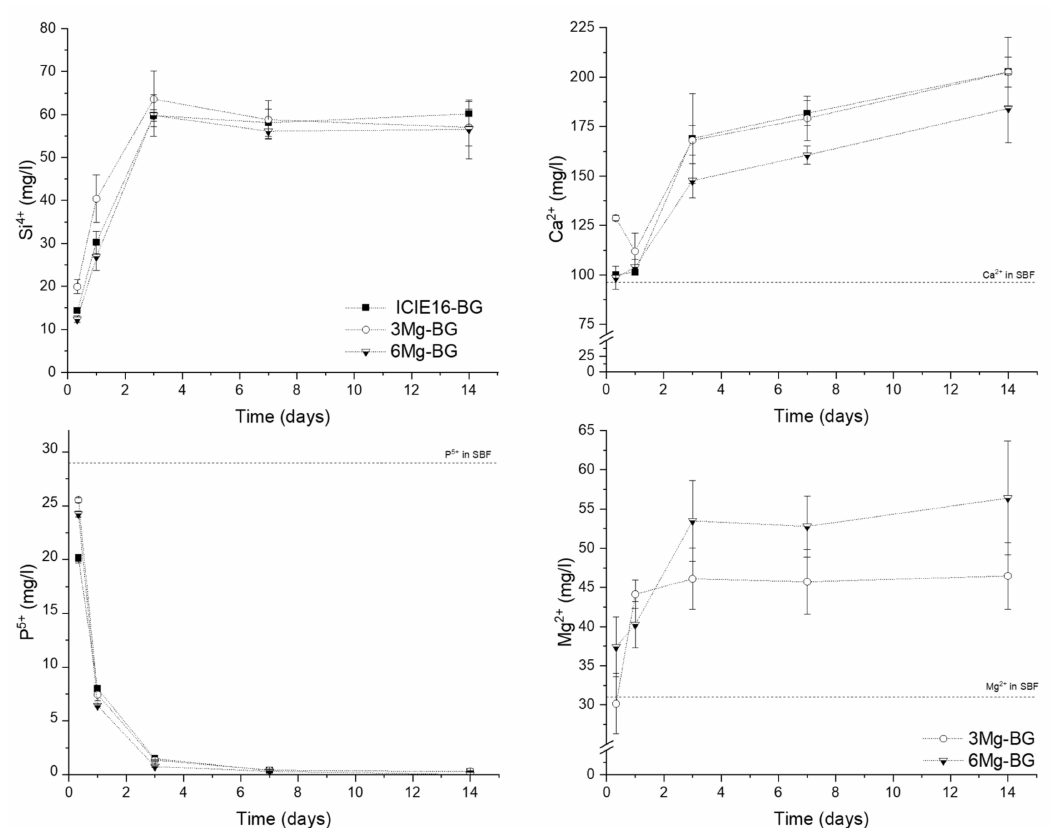
Figure 2. Ion release profiles of bioactive glasses (BGs) as function of incubation time in simulated body fluid (SBF). 2.2. Mg 2+ -Containing BGs Reduced Cell Proliferation Whilst Showing a Similar Influence on Viability as the ICIE16-BG While all BG groups significantly reduced viability compared to the control group on D1, the harmful influence of the BGs was declining with increasing incubation periods, showing no significant differences as of D14. The 6Mg-BG group showed a significantly lower cell viability compared to both control and ICIE16-BG group on D1 and D7, while it was promoting the highest viability on D14 and D21 (Figure 3a).